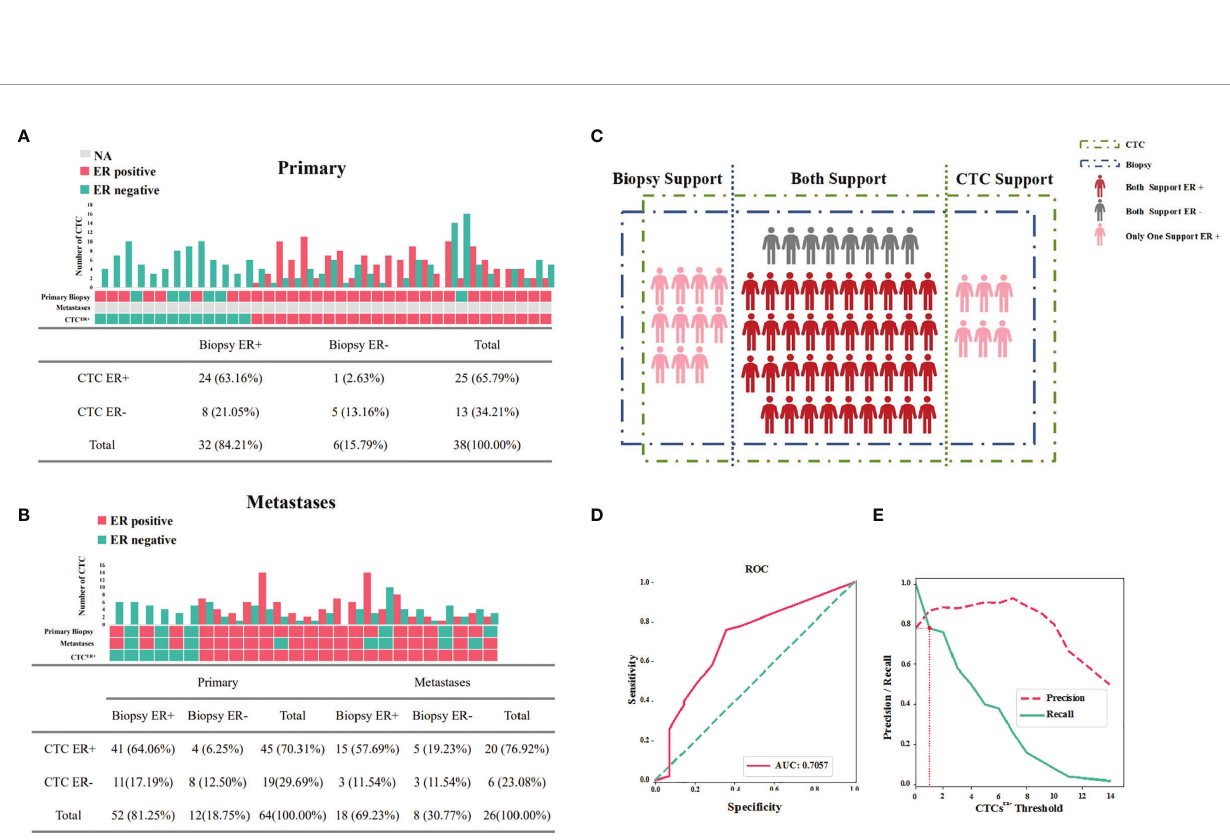
FIGURE 3 | Expression pro fi les for ER of available IHC results and CTCs. (A) Concordance/discordance in the expression of ER between CTCs and corresponding primary tumors. (B) Concordance/discordance in the expression of ER between CTCs and corresponding metastatic IHC results. (C) Distribution of ER in CTCs and corresponding IHC results of the patients with available samples. (D) The area under the curve under the assumption that the accuracy of ER detection by IHC was 100%. (E) The optimal threshold on the basis of precision-recall curve suggested that at least one ER-positive CTC within 2 ml of blood be de fi ned as CTC ER+